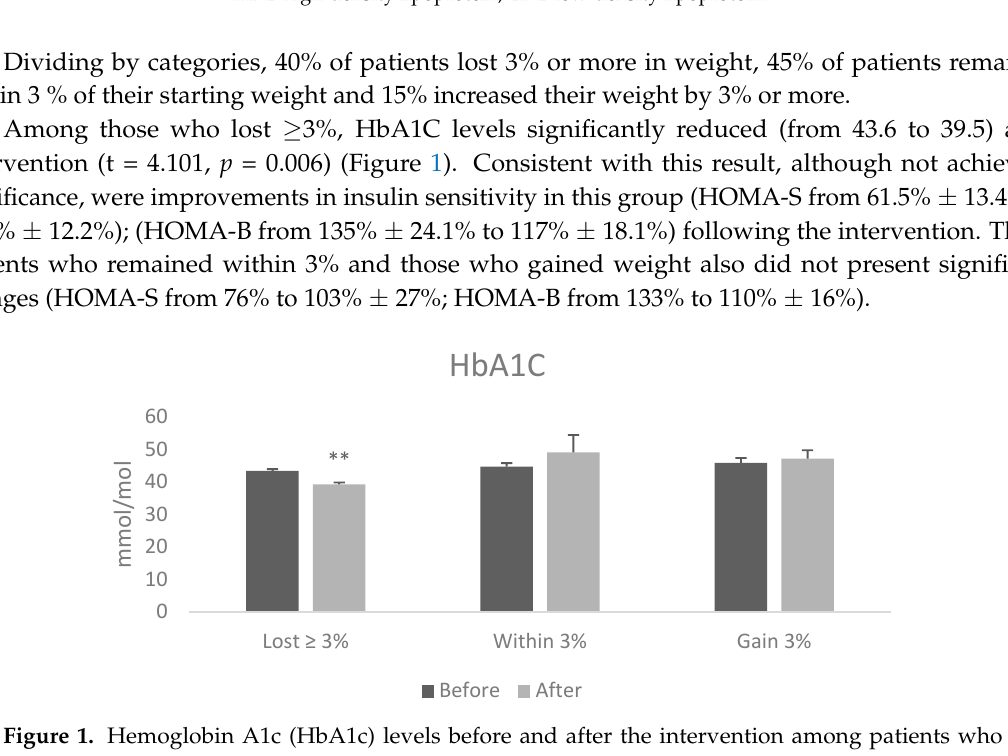
Figure 1. Hemoglobin A1c (HbA1c) levels before and after the intervention among patients who lost ≥ 3% in body weight, patients who remained within 3% of their starting weight and those who increased their weight by 3% or more. The values before and after within the groups were analysed by Paired T test and are shown as mean ± SE. ** p <